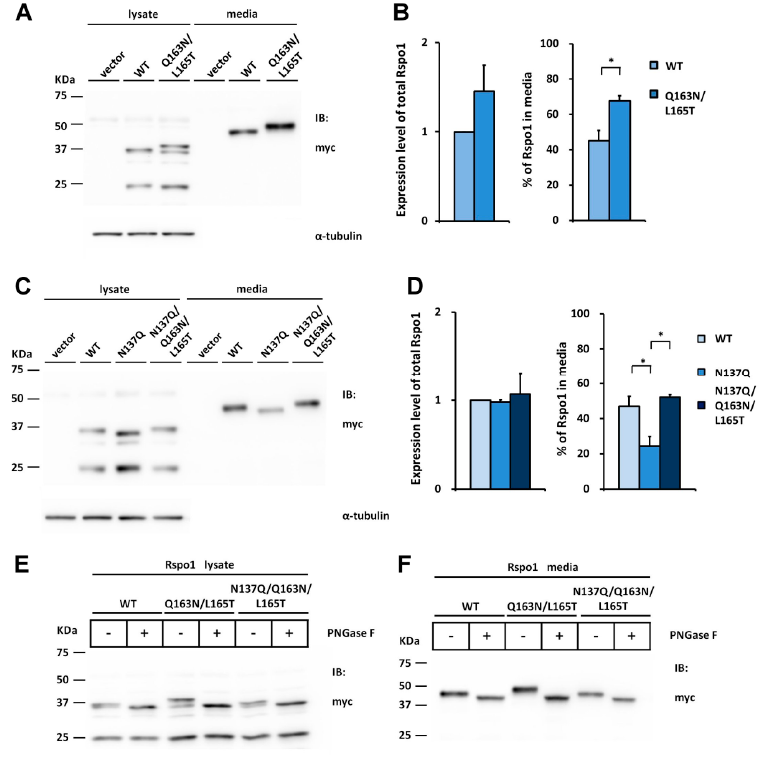
Figure 6. Introduction of the Rspo2 N-glycosylation site rescues the secretion defect of